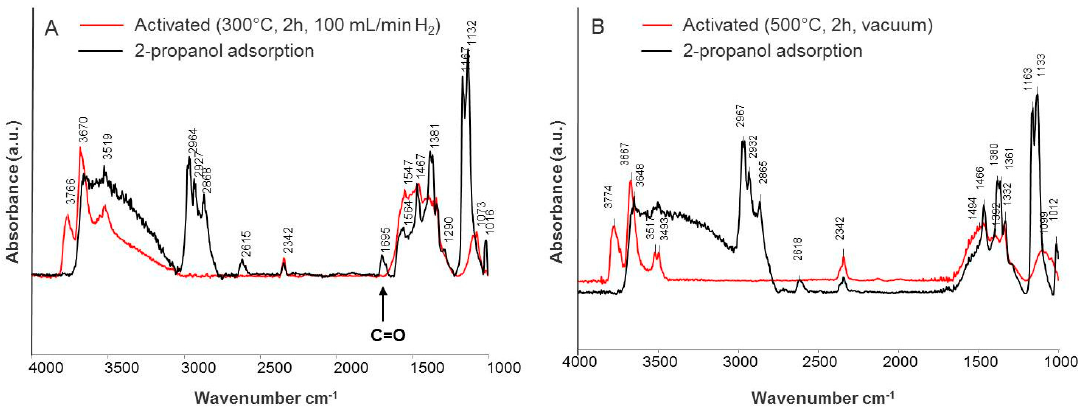
Figure 9. IR spectra of adsorbed iso -propanol on ( A ) reduced, and ( B ) oxidized CeO 2 -ZrO 2 -T.